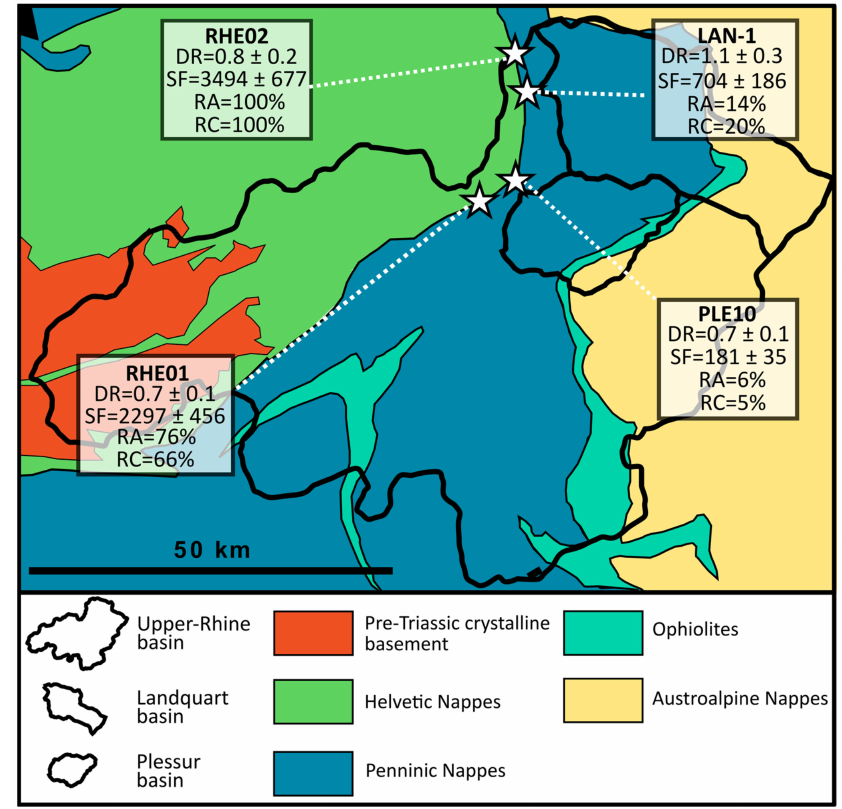
Figure 13. A simplified lithotectonic map of the Upper Rhine Basin including the Plessur and Landquart Basins, and their respective denudation rates (DR) in mm a − 1 , sediment flux (SF) in 10 3 m 3 a − 1 , relative area (RA), and relative contribution